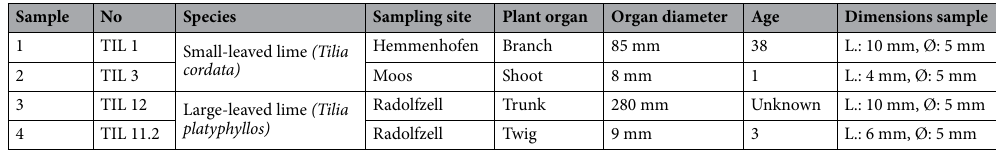
Table 1. Samples from recent lime bark.